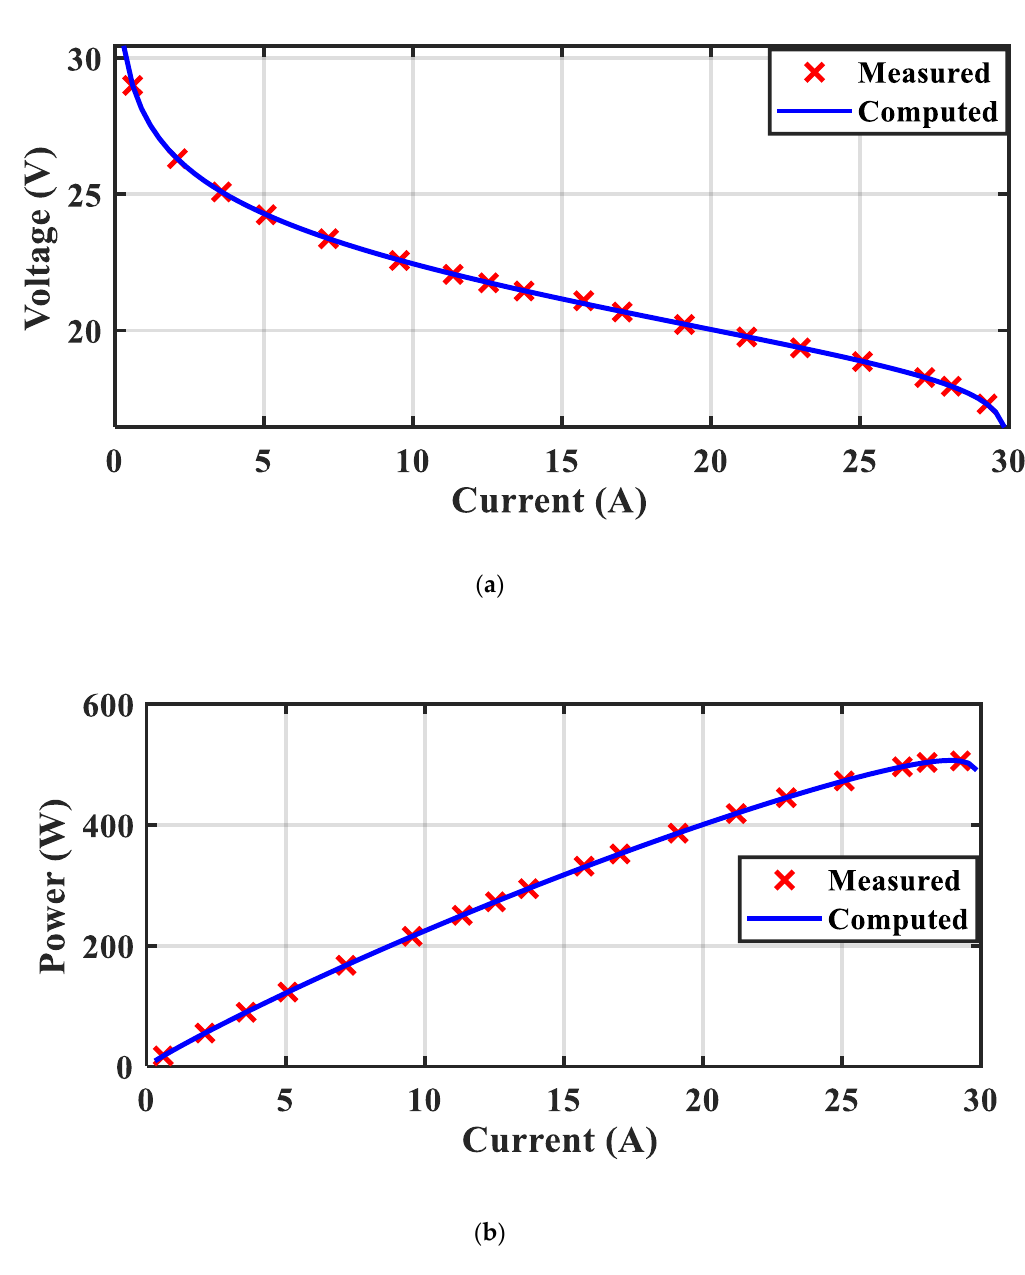
Figure 7. Polarization curves of BCS fuel cell using the HGS algorithm. ( a ) I–V curves. ( b ) I–P curves.